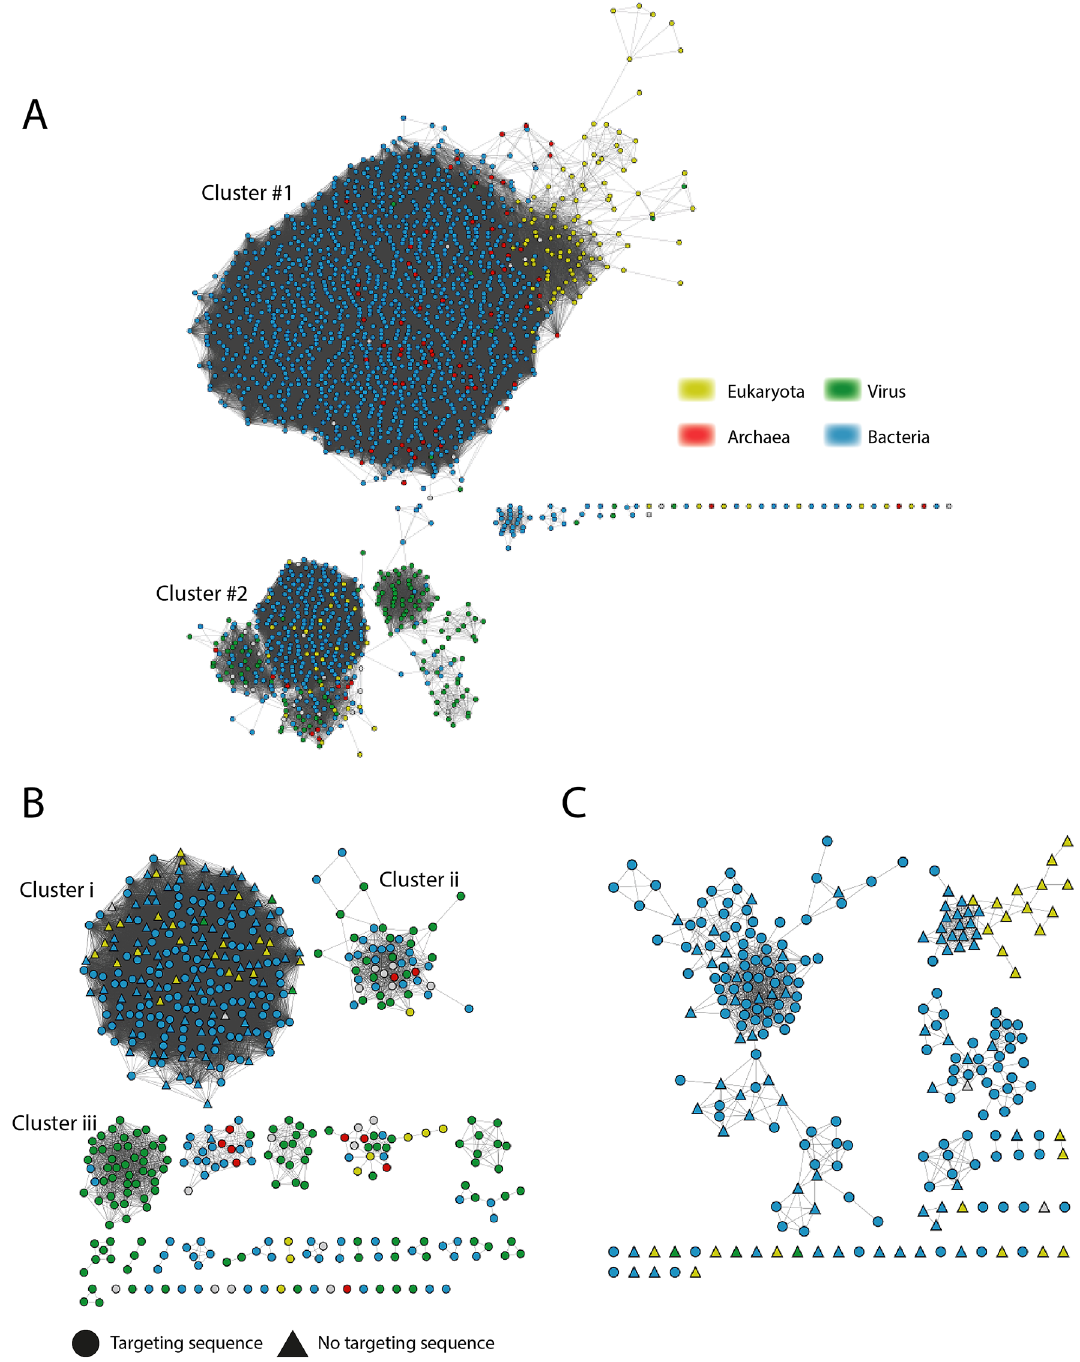
Figure 1. Repnode Sequence Similarity Network of DNA ligases 250–370 amino acids long. ( A ) Clusters of all sequences at 22% edge cutoff. ( B ) Cluster #2 refined to 37% edge cutoff. ( C ) Cluster i refined to 52% edge cutoff. Nodes throughout are coloured by repnode taxa as indicated in the key (Eukaryotes, yellow; Archaea, red; Viruses, green; Bacteria, blue). For panels ( B , C ), the presence or absence of a leader sequence is indicated by node symbol shape (circle and triangle,